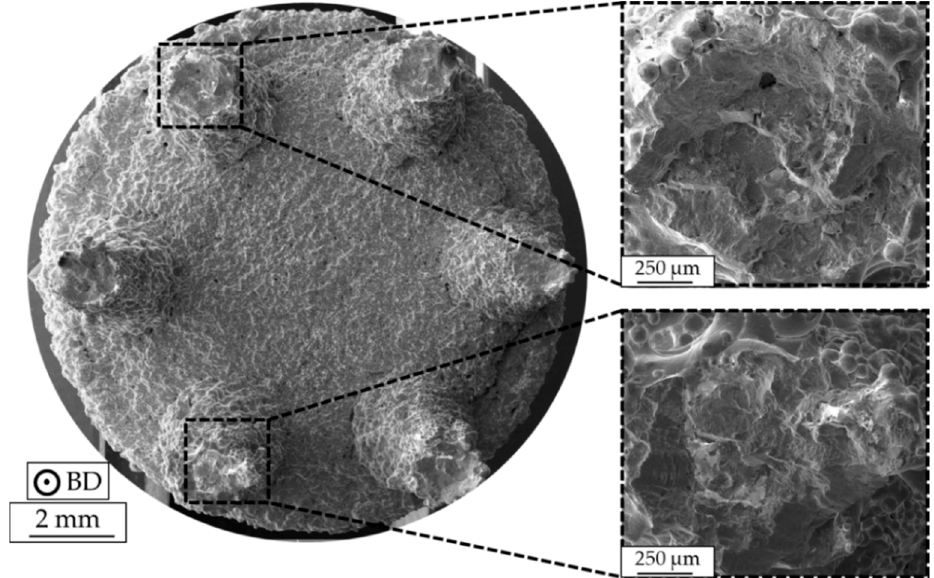
Figure 12. Fracture surface of an as-built specimen with a strut diameter of 2 mm, tested at a stress amplitude of σ a = 105 MPa (N f = 18,174